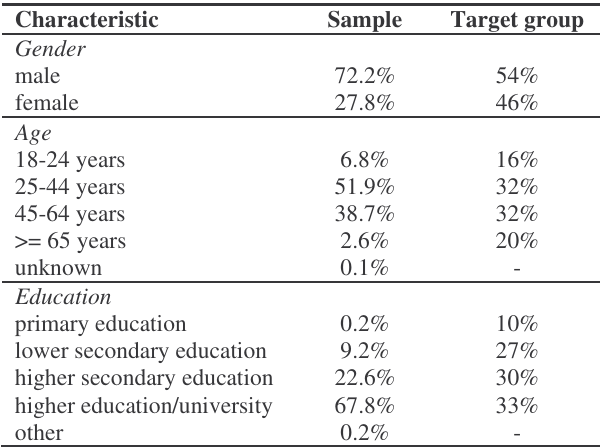
Table 2. Characteristics of the sample and target group Characteristic